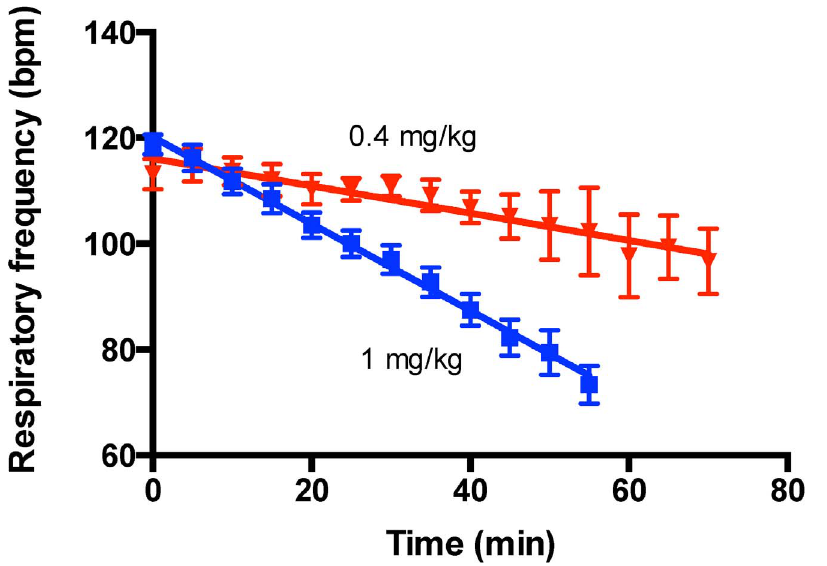
Figure 2. Effect of Ptx venom dose on rat respiration rate. Venom injected into a hind foot of each anaesthetized rat caused an approximately linear decline in respiration frequency before sudden arrest with the slope of the decline shallower at the lower venom dose (n=16 & 7 for 1 mg/kg & 0.4 mg/kg respectively).